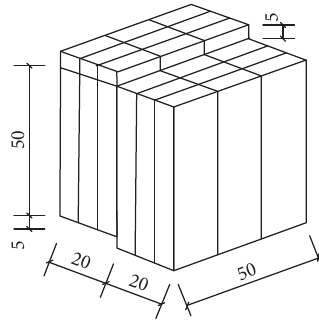
Figure 5: Size of shear